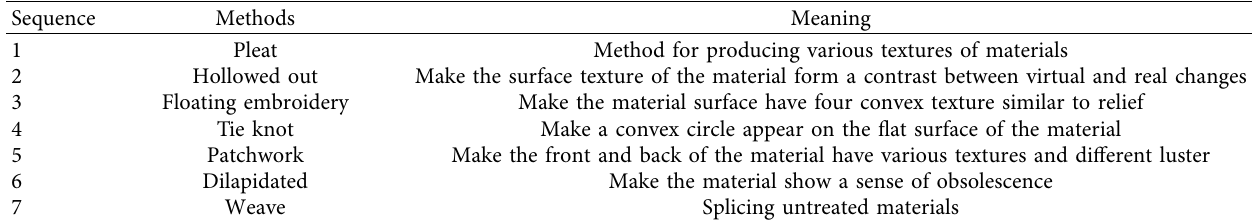
Table 2: Fashion design expression means of the same